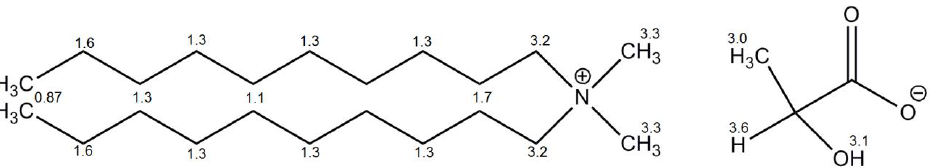
Figure 10. Structural formula of DDALa with marked protons.